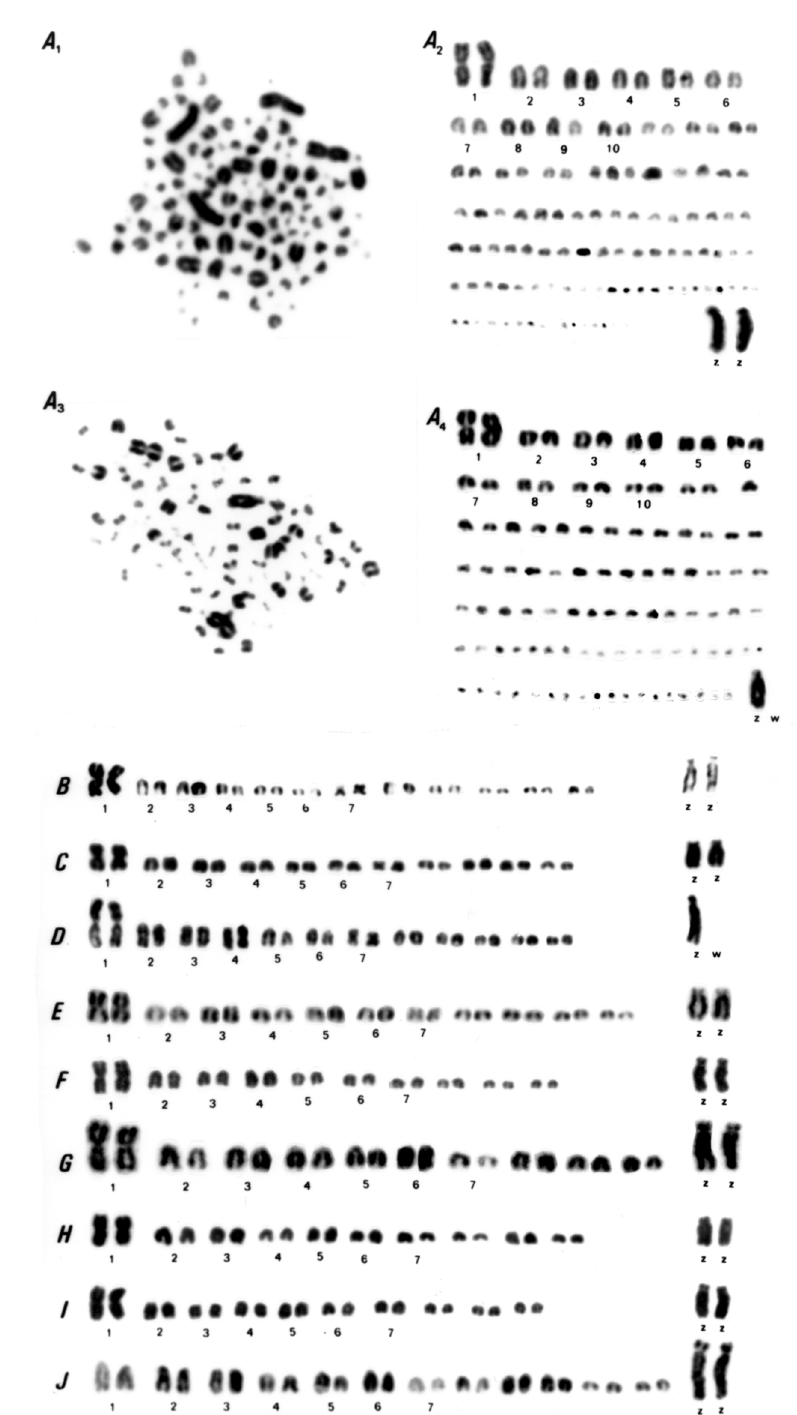
Figure 1 - A 1 . Mitotic metaphase of R. toco (male), A 2 . karyotype of R. toco (male), A 3. Mitotic metaphase of R. toco (female) , A 4. Karyotype of R. toco (female) . Partial karyotypes of B. Ramphastos dicolorus, C. R. ariel , D. R. vitellinus, E. R. tucanus cuvieri, F. Baillonius bailloni, G.